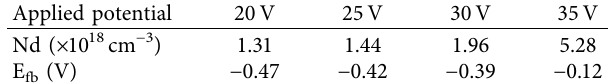
Table 3: Electrical parameters of titanium oxide. Applied